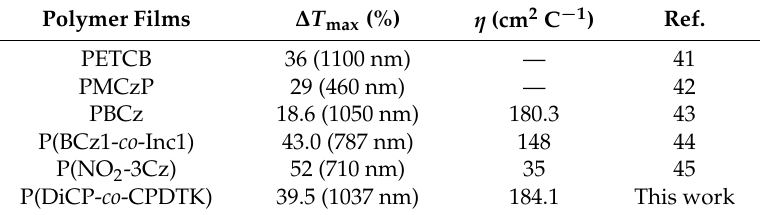
Table 4. Transmittance changes and colouration efficiencies of carbazole-based polymer